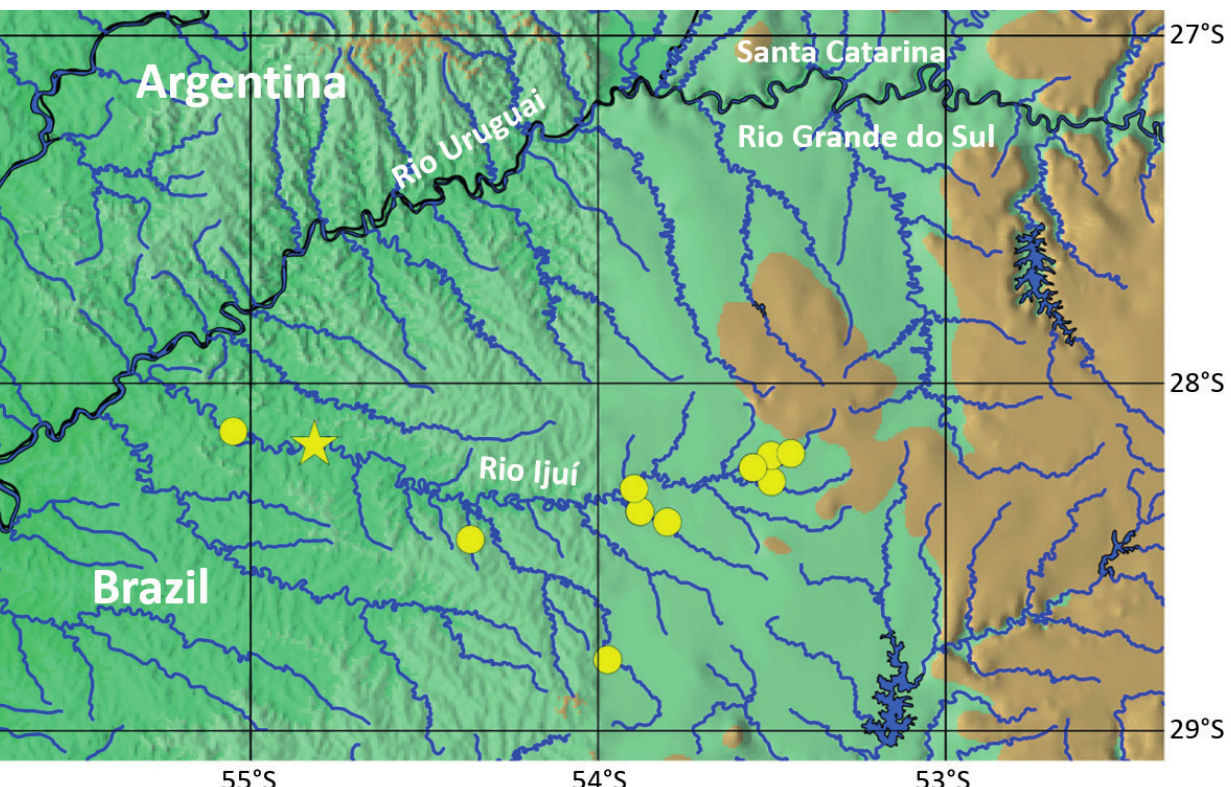
FIGURE 3 | Distribution of Pareiorhaphis pumila in south Brazil. Star = holotype; dots = other specimens. Each symbol may represent more than one lot or locality.